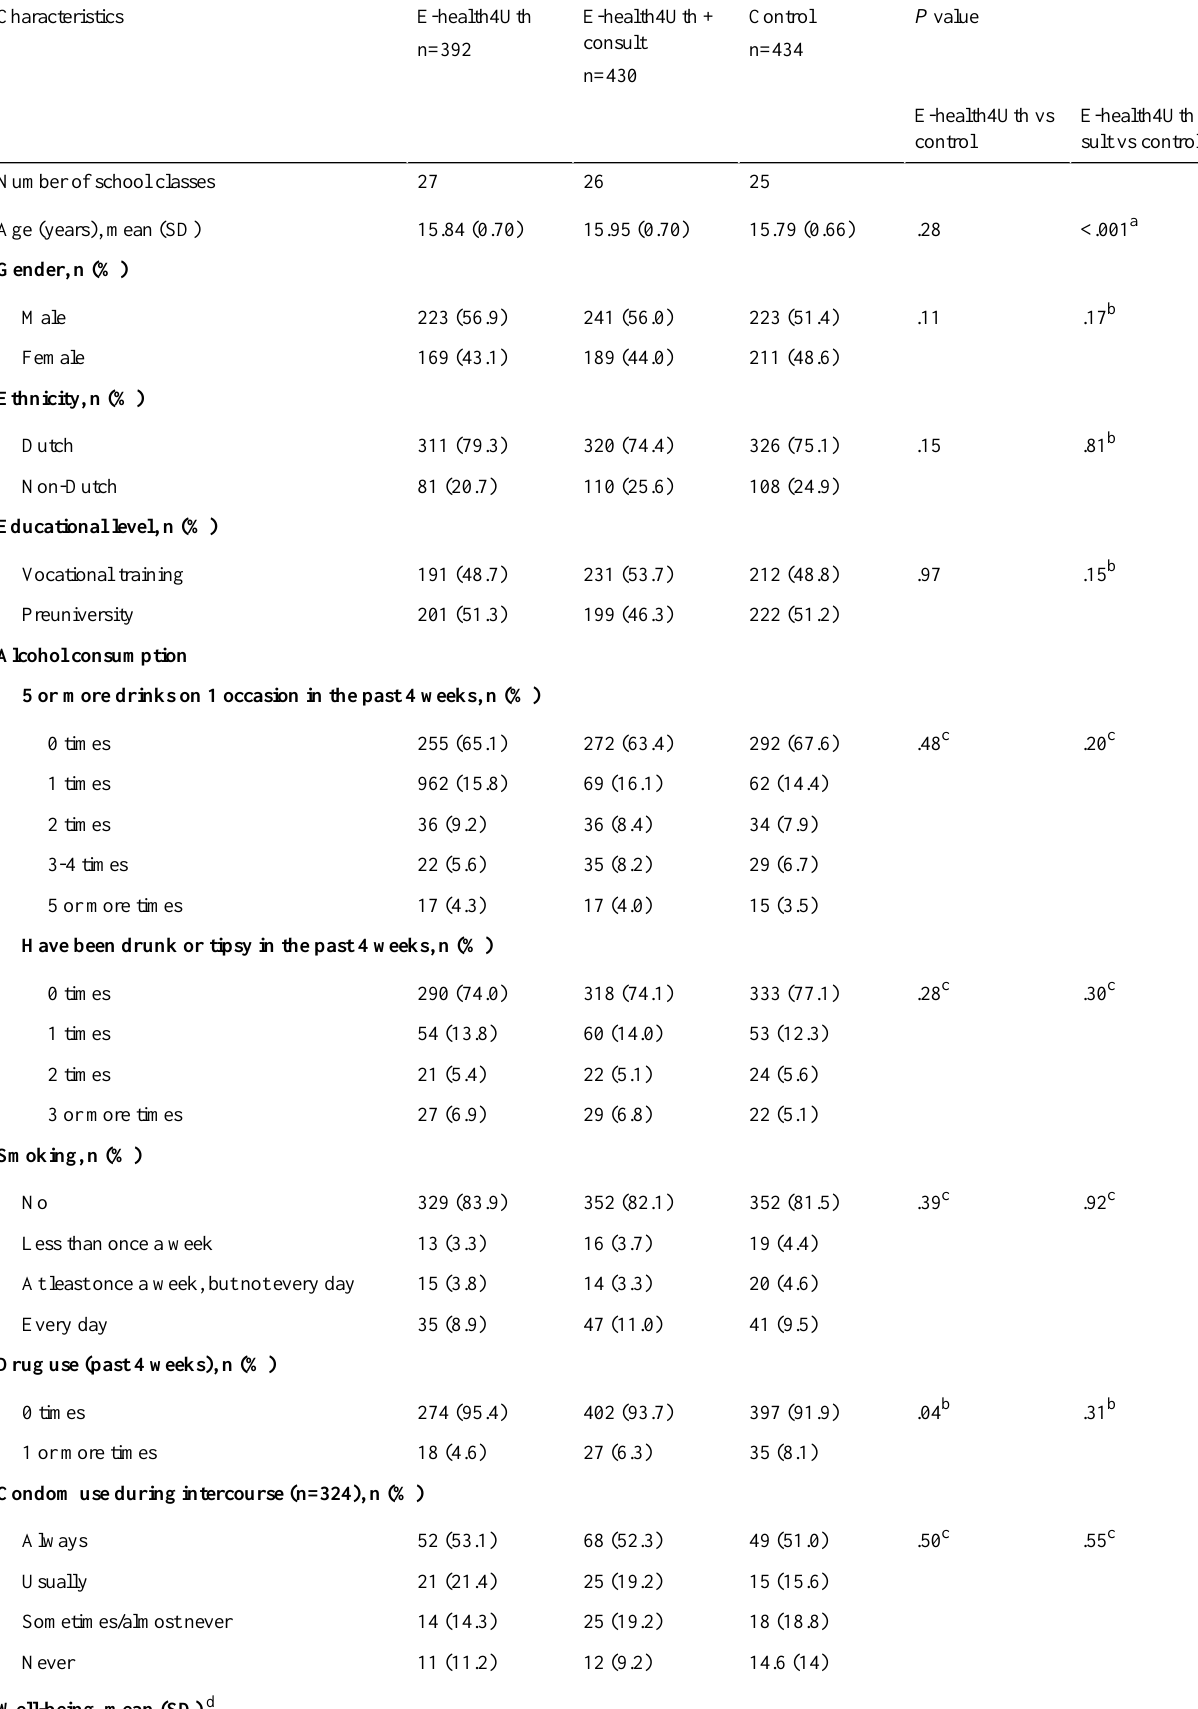
Table 1. General characteristics and baseline health behaviors and well-being of adolescents for the intervention groups and control group